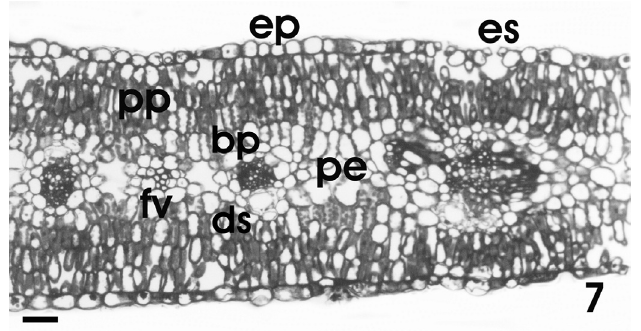
FIGURA 7 – B. microcephala – Secção transversal da ala do cladódio. bp: bainha parenquimática; ds: duto secretor; ep: epiderme; es: estômato; fv: feixe vascular; pe: parênquima